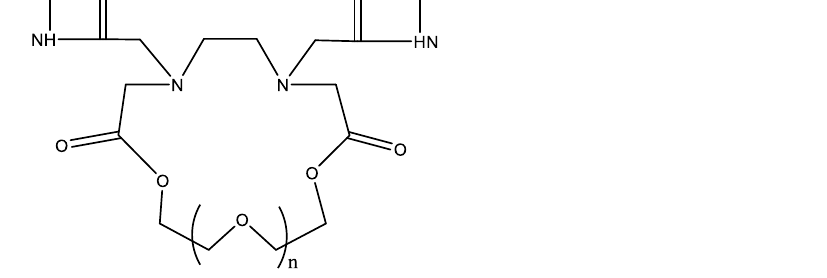
Figure 2. Example of the aza-crowned dihydroxamic acid, n = 0 – 4. Adapted from